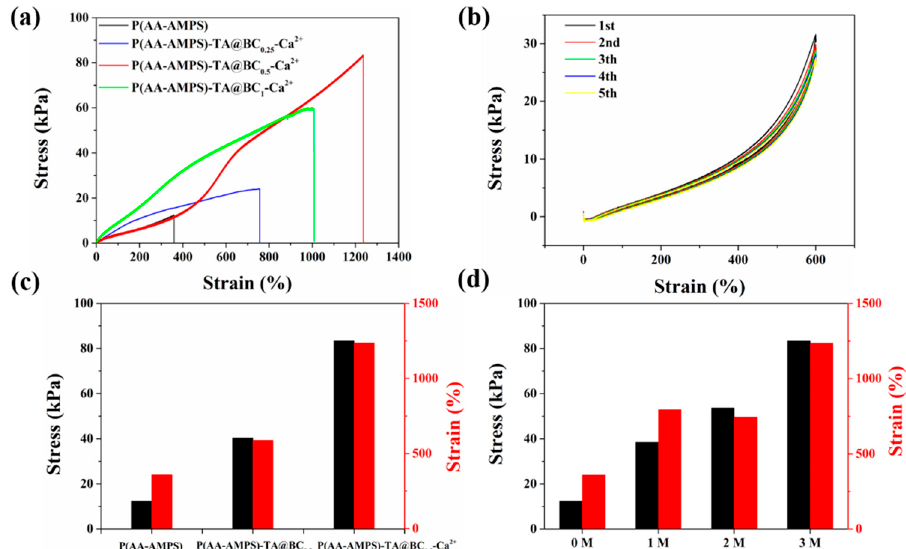
Figure 3. Tensile properties of hydrogel. ( a ) Tensile stress–strain curves of P(AA ‐ AMPS) ‐ TA@BC ‐ Ca 2+ hydrogels with different concentrations of TA@BC; ( b ) stretch–release cycle (600%, 5 cycles) of P(AA ‐ AMPS) ‐ TA@BC 0.5 ‐ Ca 2+ hydrogel; ( c ) tensile stress–strain histogram of P(AA ‐ AMPS), P(AA ‐ AMPS) ‐ TA@BC 0.5 , and P(AA ‐ AMPS) ‐ TA@BC 0.5 ‐ Ca 2+ hydrogels (black columns: stress, red columns: strain); ( d ) tensile stress–strain histogram of P(AA-AMPs)-TA@BC-Ca 2+ hydrogels with different concentrations of Ca 2+ ions (black columns: stress, red columns: